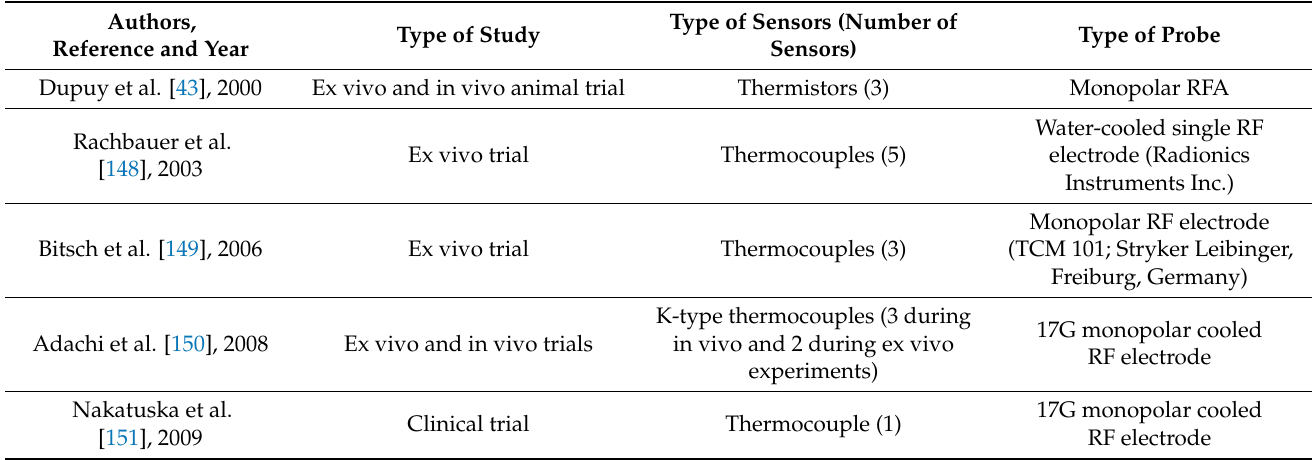
Table 2 summarizes studies performing temperature monitoring during RFA in bone. Table 2. Studies performing temperature monitoring in bone during